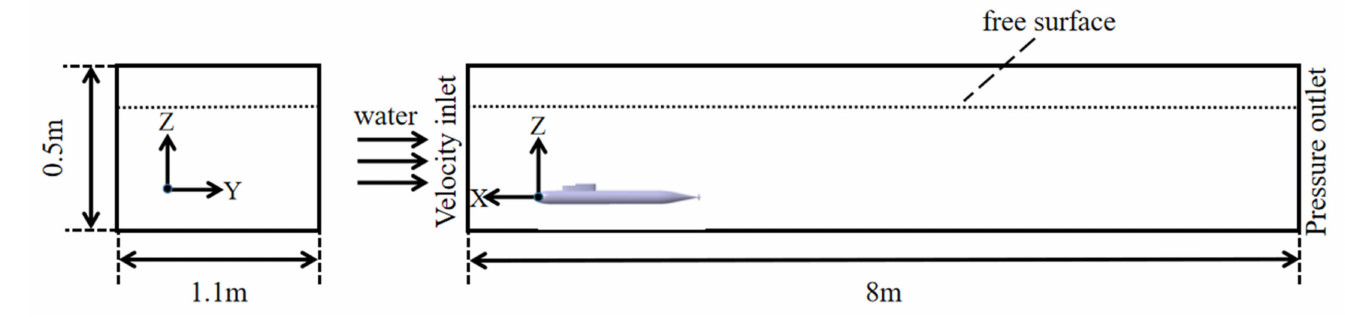
Figure 1. Diagram of fluid computing